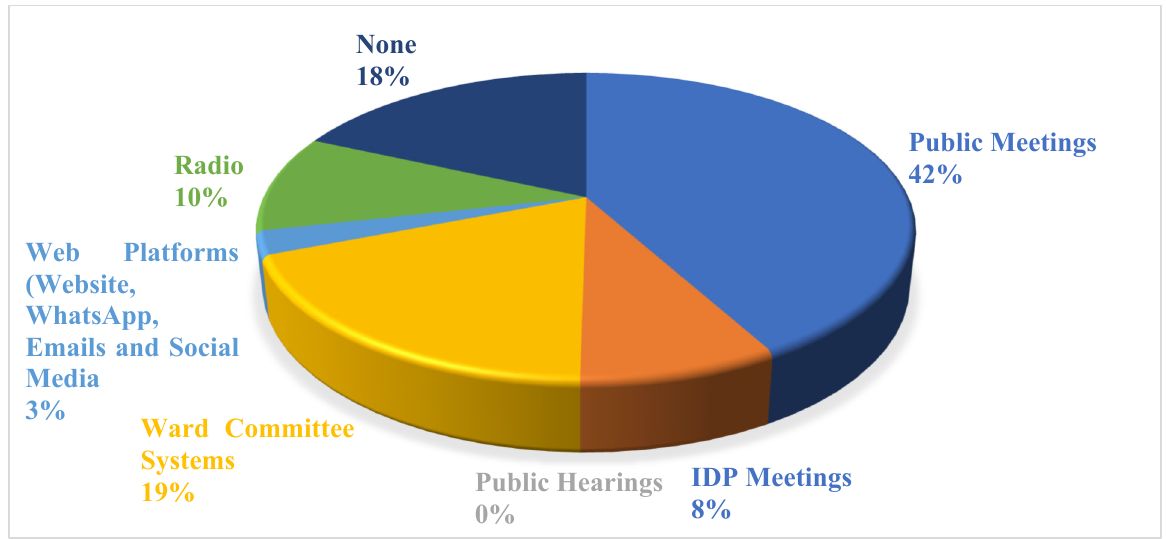
Figure 1. Most Used Mechanisms and Best Applied. Source (Mamokhere and Meyer 2022).